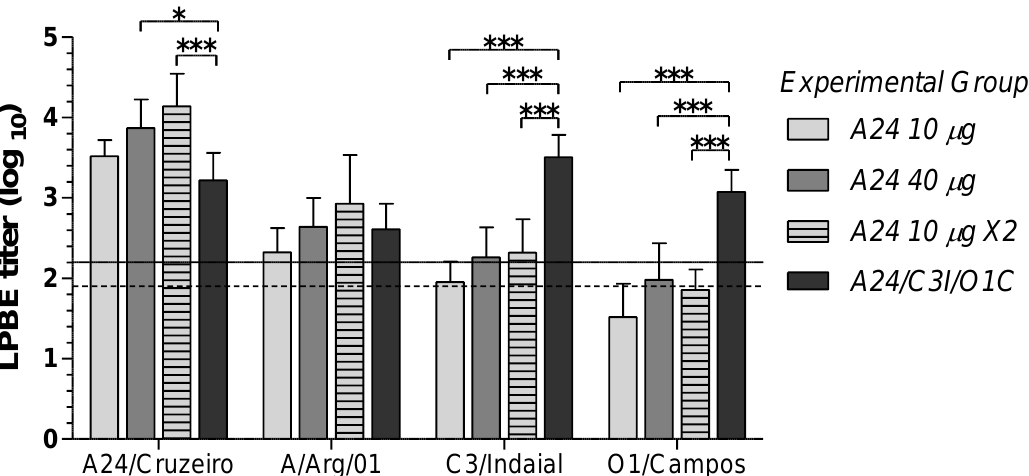
Figure 2. Total FMDV-specific antibodies induced in each experimental group at 30 days post- primary vaccination (dpv). Total anti-FMDV antibody titers measured by liquid-phase blocking ELISA (LPBE) against the A24/Cruzeiro, A/Arg/01, C3/Indaial, and O1/Campos FMDV strains. Results are expressed as the log10 of the mean LPBE titer in each experimental group at 30 dpv before heterologous challenge. Bars represent mean values of each experimental group ± SD. Dotted and black lines depict the titers corresponding to the expected percentage of protection ≥ 75% (EPP 75 ) for A24/Cruzeiro (1.90) and A/Arg/01 (2.20) strains, respectively. Asterisks denote statistical differences between experimental groups (ANOVA) * p ≤ 0.05; *** p ≤ 0.001.